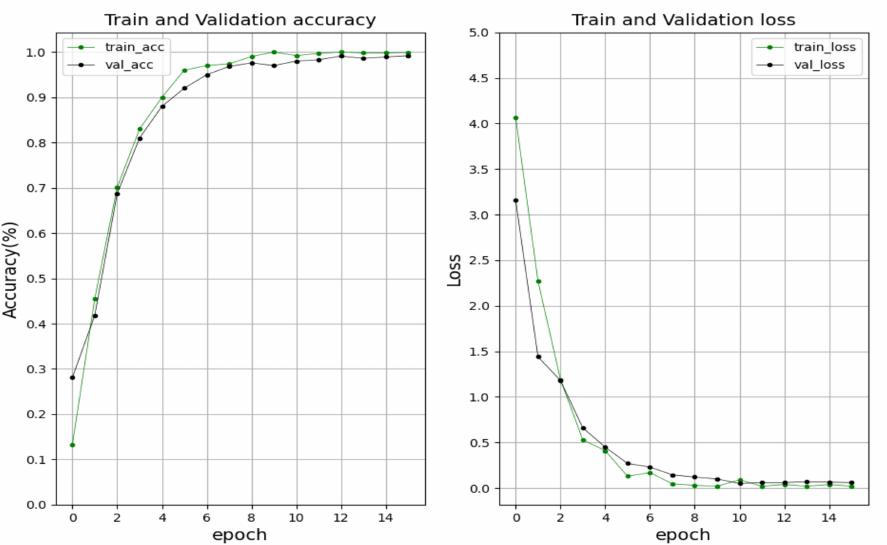
Figure 9. The training and validation performance (accuracy and loss) of the character recogni- tion